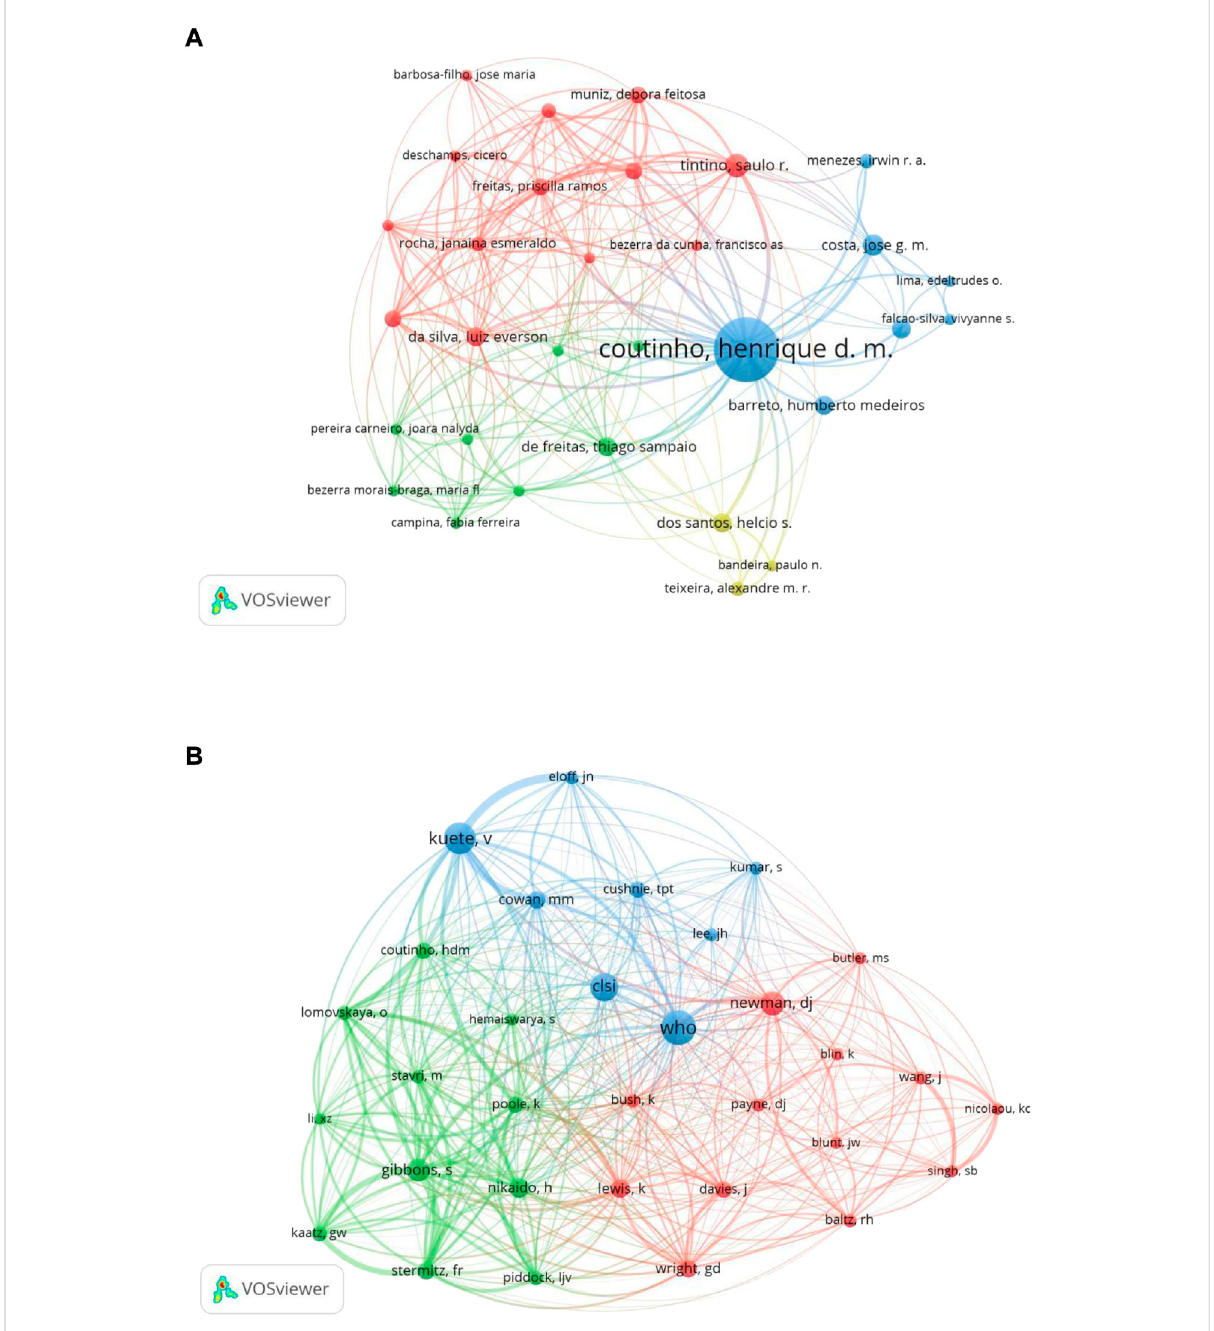
FIGURE 5 Network visualization map of authors (A) and co-cited authors (B) related to resistance of natural products to MDR